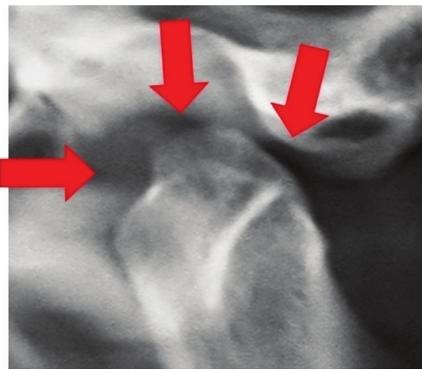
Figure 8: Showing presence of scooped out area of erosion in posterosuperior aspect of head of condyle giving appearance of mouthpiece of flute.